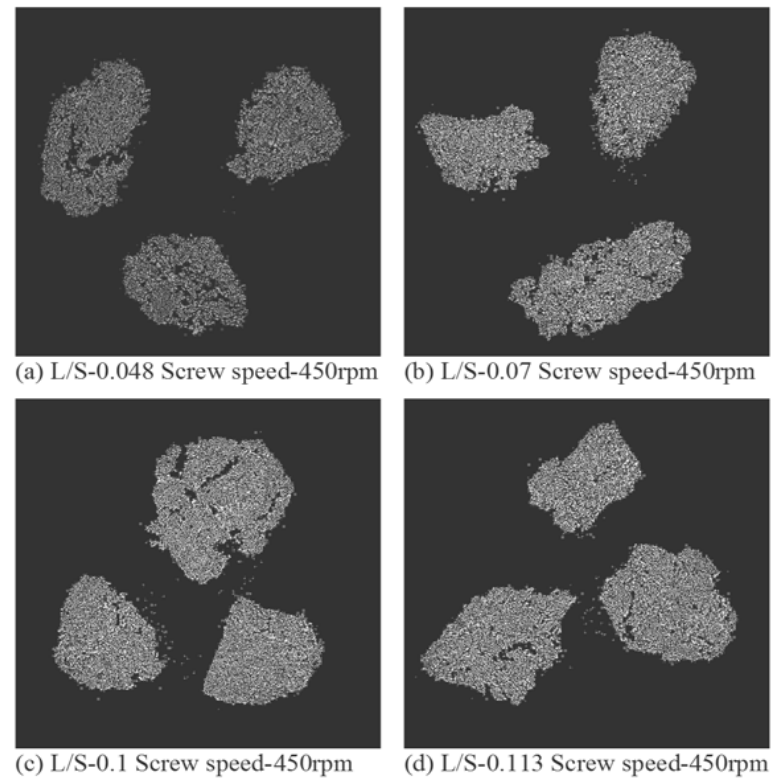
Figure 11. X ‐ ray tomographic images of granules produced using Pearlitol 50C at varying L/S (screw speed, 450 rpm).